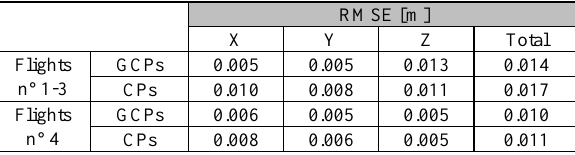
Table 7. Metric control of the UAV